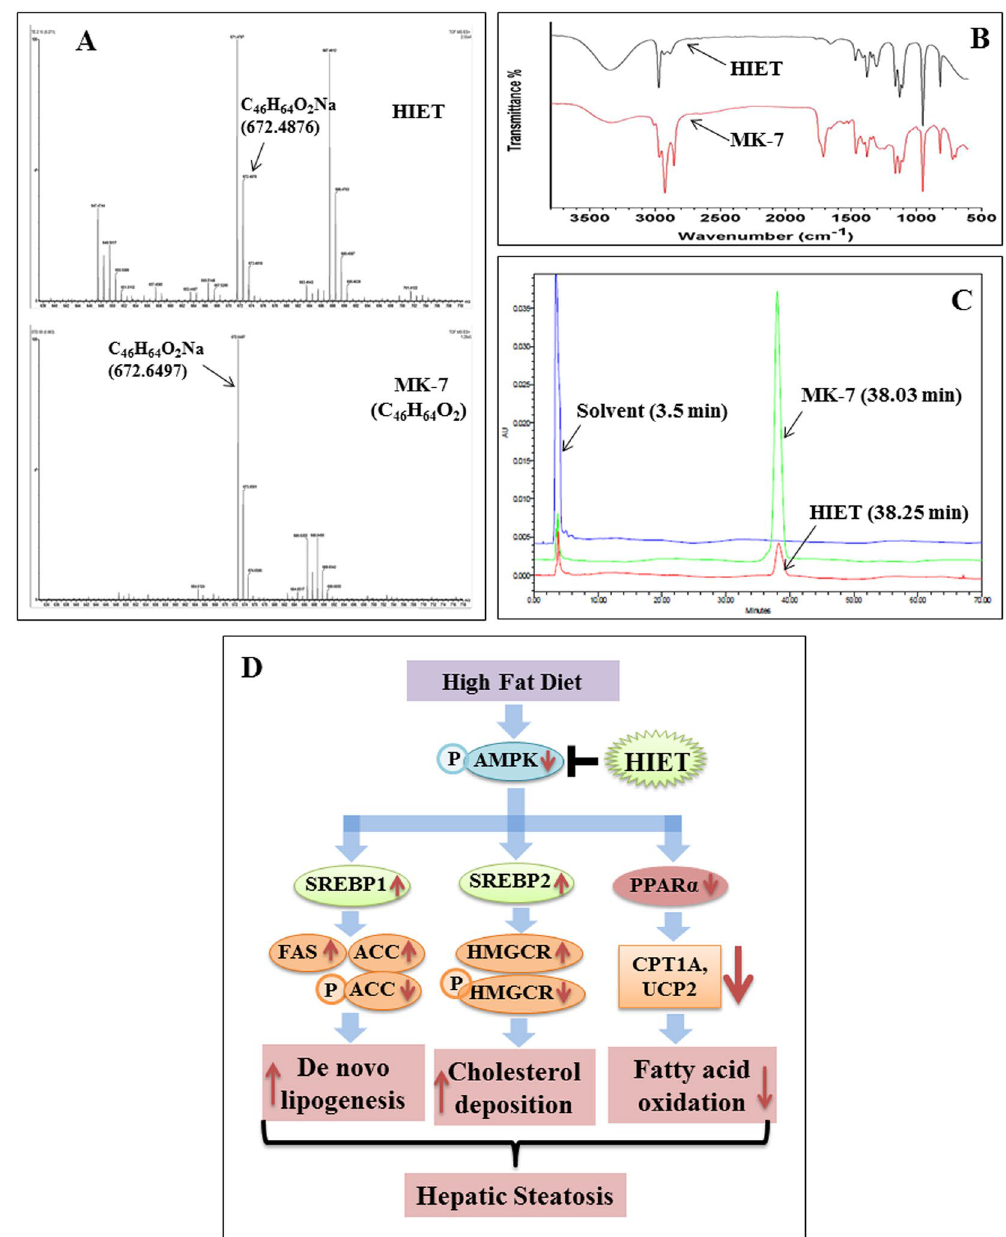
Figure 5. Chemical profiling of HIET and schematic diagram of proposed mechanism underlying the beneficial role of HIET against hepatic steatosis. ( A) HRMS; ( B ) IR; ( C ) HPLC; and ( D ) proposed